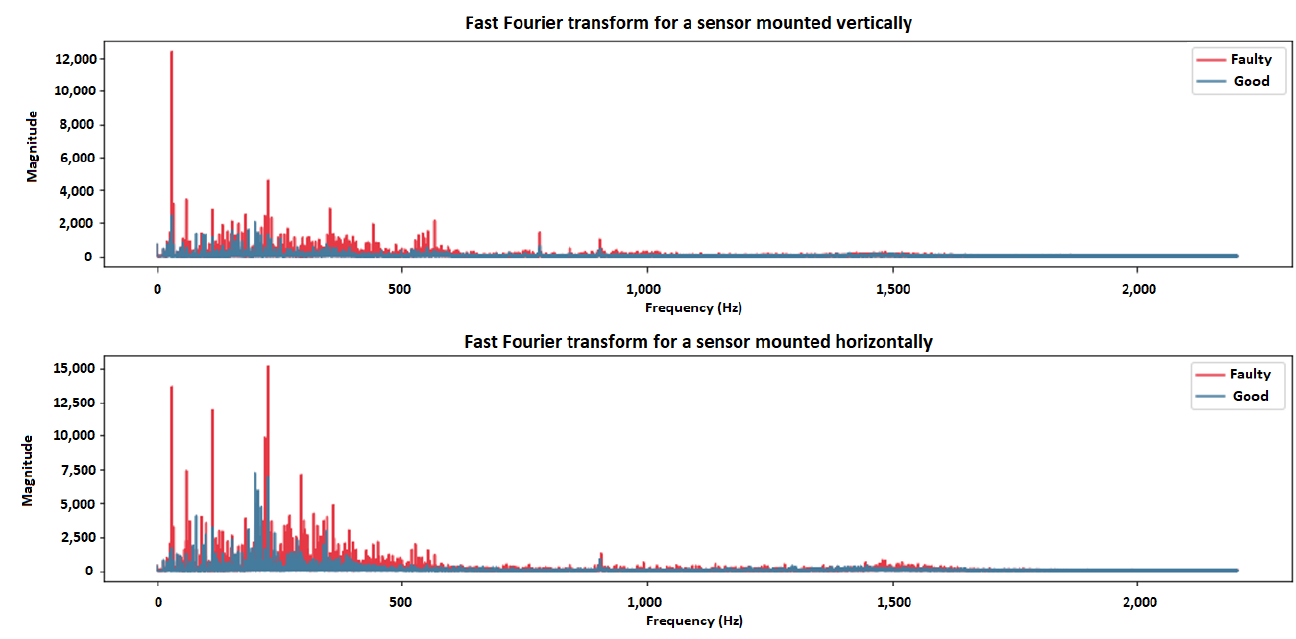
Figure 5. Fault belt drive and pulley analysis.